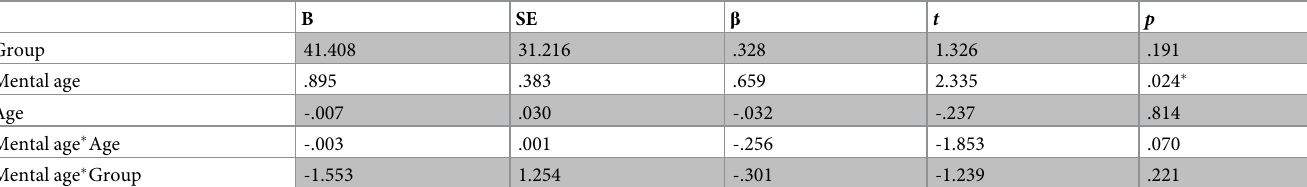
Table 2. Summary for model fit (predicting Hit rate change following the second target switch). � p <